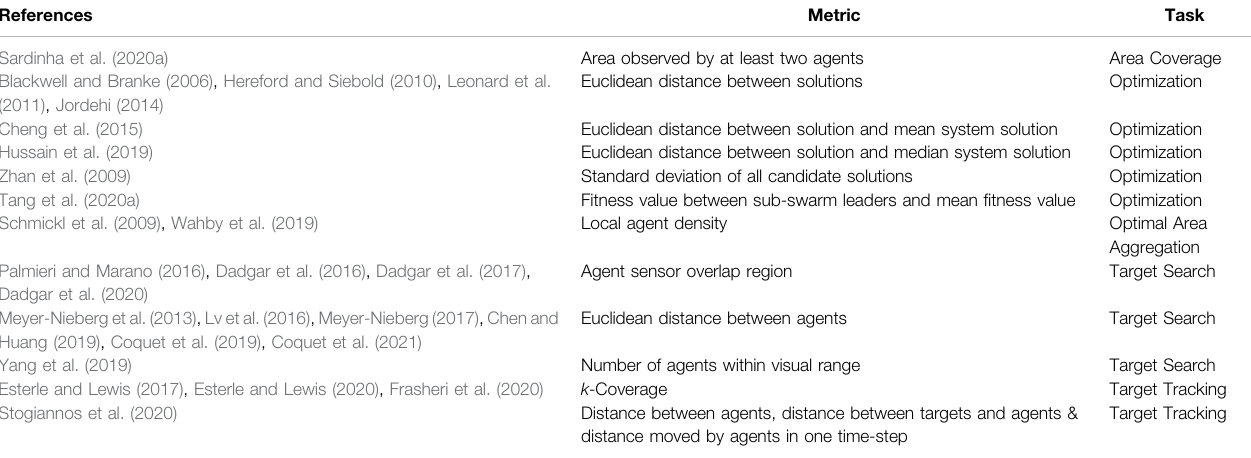
TABLE 1 | List of works using spatial distribution metrics to quantify MAS exploration and